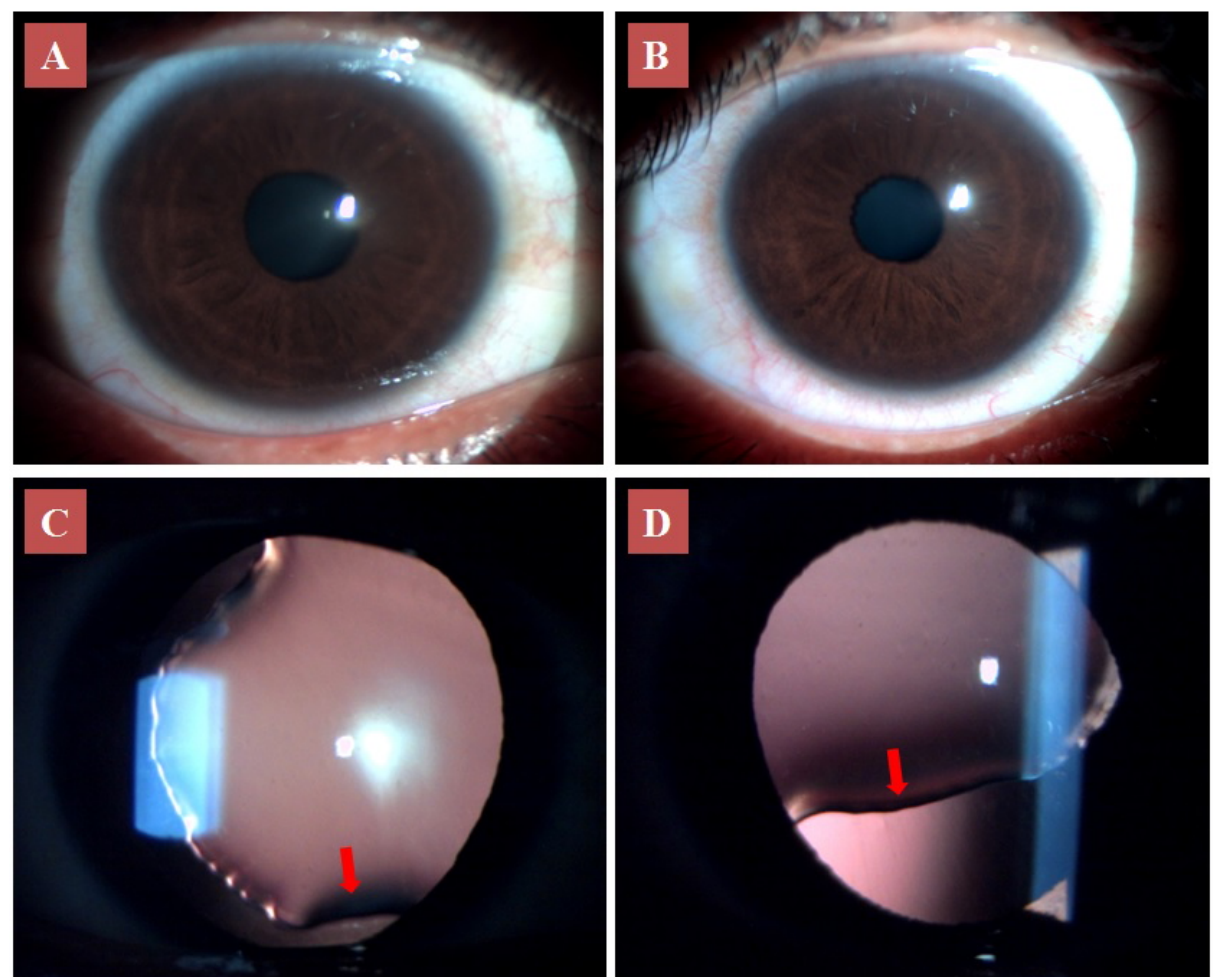
Figure 1: Anterior segment photo of the right (A) and left eye (B) in undilated pupil. Retroillumination view under mydriasis of the right eye (C) showing ectopia lentis with lens coloboma (arrow) and the left eye (D) showing ectopia lentis with lens coloboma and stretched zonules (arrow).